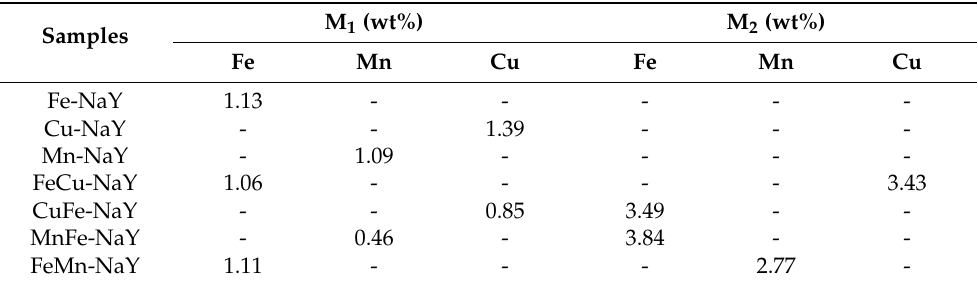
Table 1. Inductively coupled plasma atomic emission spectroscopy (ICP-AES) results for the mono (M 1 -NaY) and bimetallic (M 1 Me 2 -NaY) catalysts.